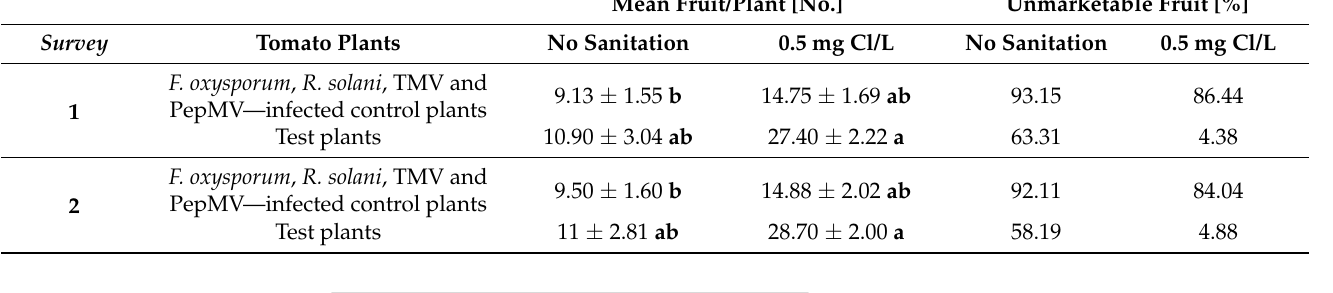
Table 2. Number of tomato fruits and non-marketable fruits of tomato plants grown in an NFT hydroponic system with recirculating fertigation solution dependent on a sanitizing treatment during a harvest period of 10 weeks. Mean values are shown for infected control plants (n = 8) and test plants (n = 10). Control: no sanitation, sanitation: 0.5 mg free chlorine/L for 60 min, weekly. Fruits with discoloration, of diameter less than 40 mm or cracks, were considered unmarketable. Significance of comparisons were calculated using Tukey-test with values differing significantly from each other ( p < 0.05) being annotated by different letters (a, b). Values prefixed with ± represent the standard deviation. The number of tomatoes not marketable due to color changes or insufficient fruit size was dependent on the infecting pathogen. The fruit size of all infected plants was reduced Mean Fruit/Plant [No.]